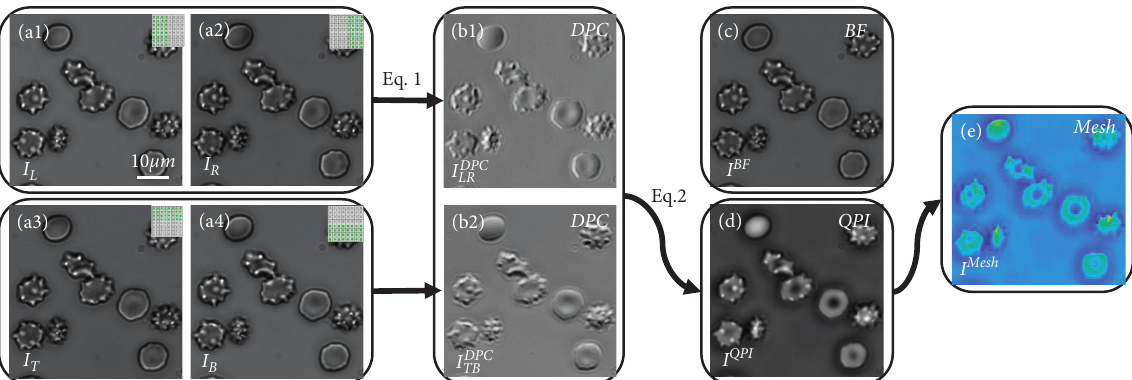
Figure 5: QPI visualization and BF images of RBCs (a1)–(a4) are the oblique illumination images of the LED array in the left, right, top, and bottom illuminations, respectively; (b1)-(b2) are the left-right and top-bottom DPC images, respectively; (c) RBC bright field image; (d) reconstructed QPI; (e) mesh of QPI. The upper right corner of the picture shows the lighting mode of the LED